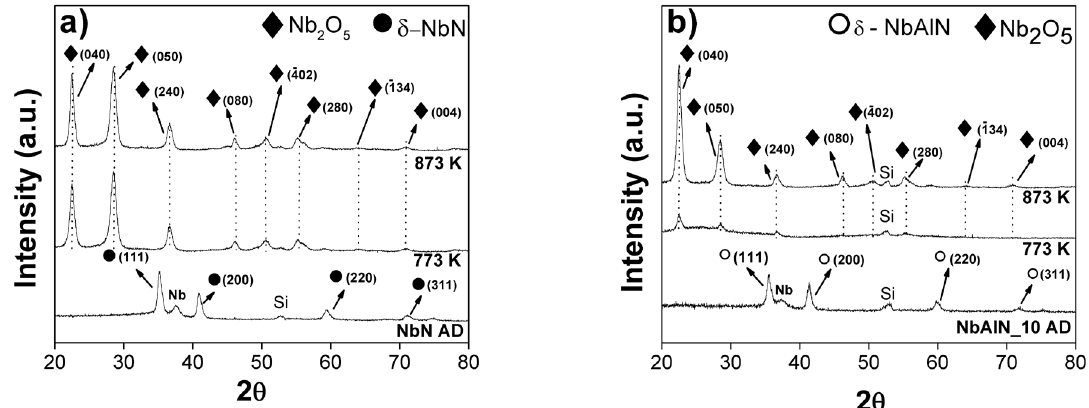
Figure 5. GAXRD patterns for (a) pure NbN and (b) NbAlN_10 sample as deposited and after oxidation tests at 773 and 873